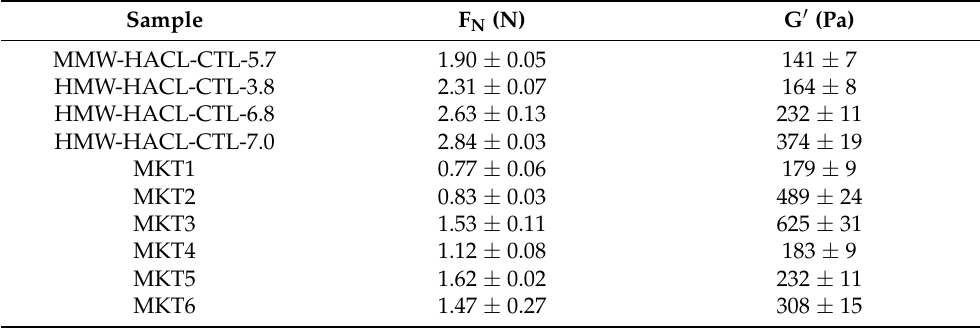
Table 4. Normal force (F N ) exerted and elastic modulus (G (cid:48) ) at 1 Hz of HACL-CTL fillers and commercial